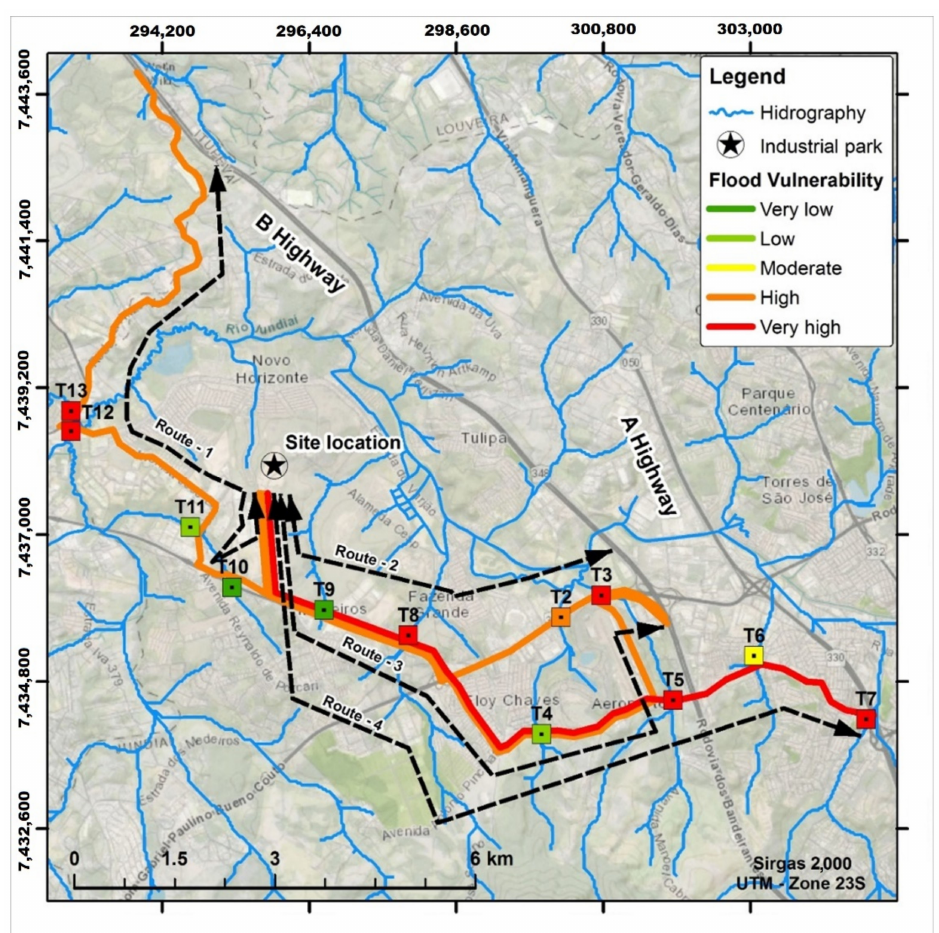
Figure 6. Flood vulnerability of potential routes to access the industrial park